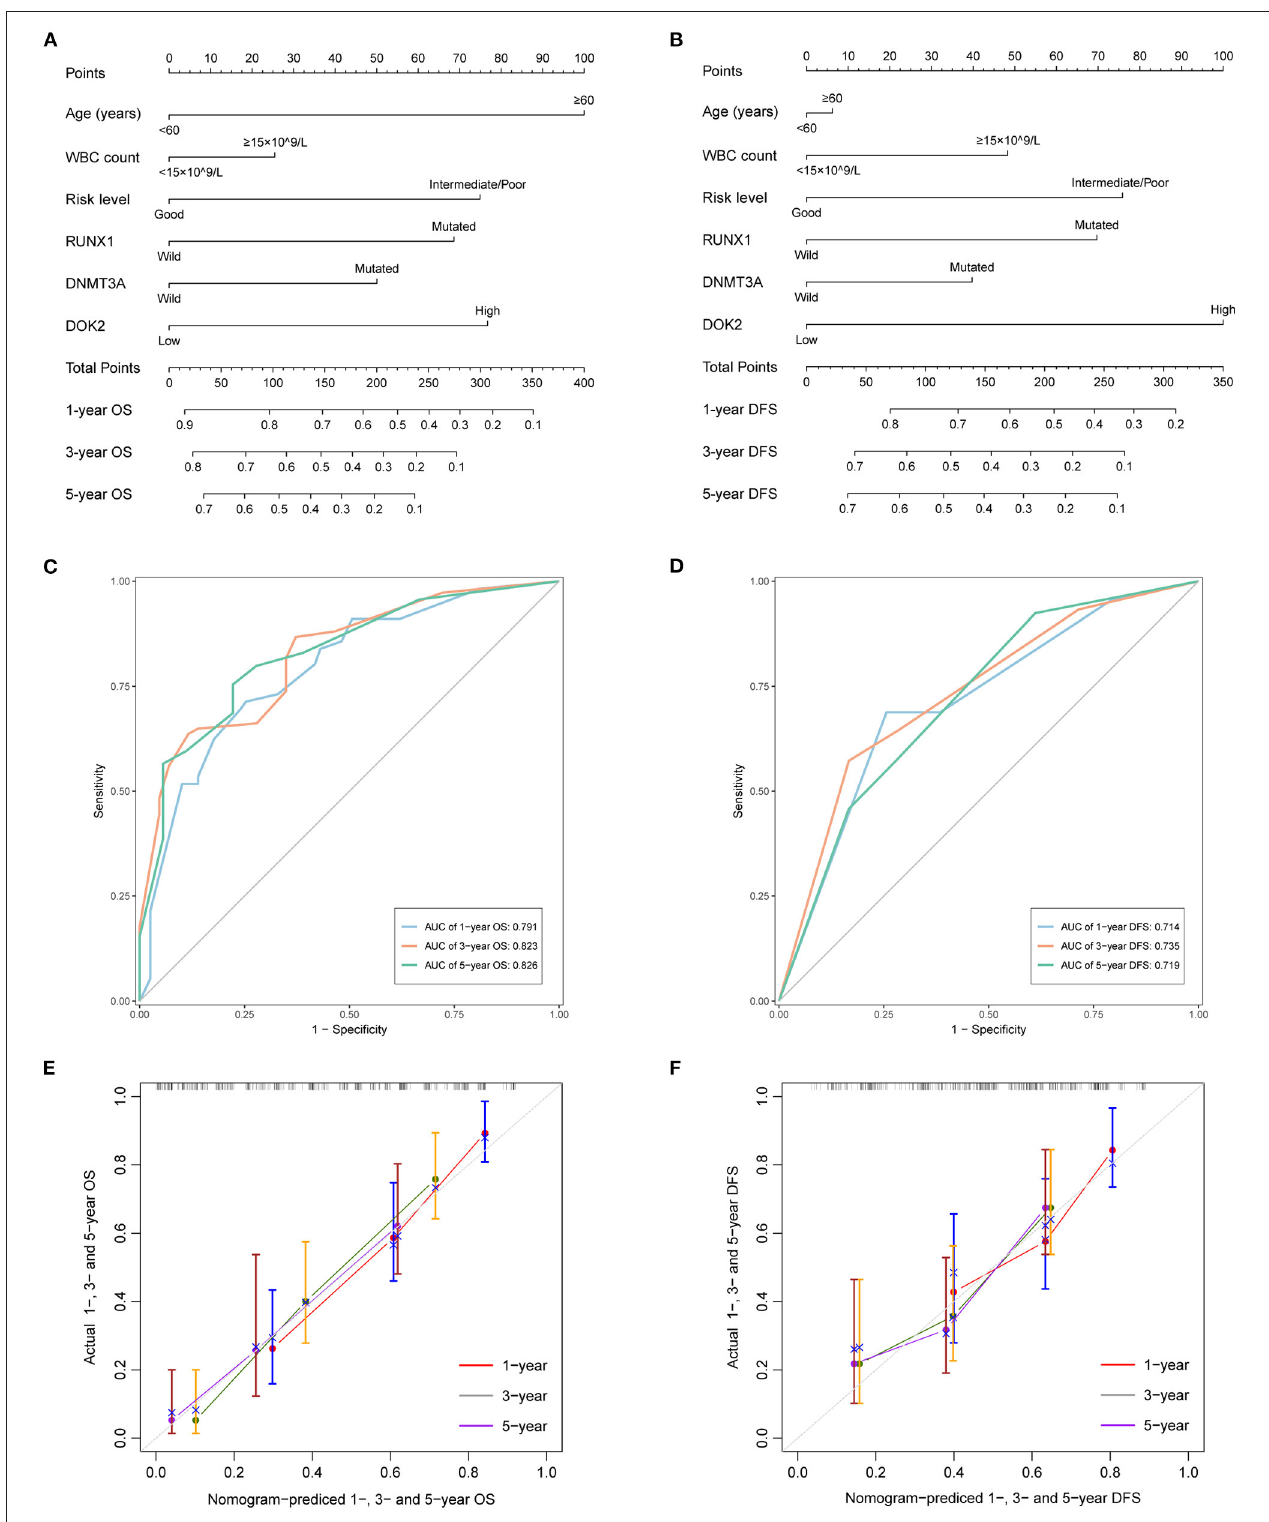
FIGURE 4 | Predictive nomograms for TCGA AML patients. (A) Nomogram for predicting 1-, 3-, and 5-year OS. (B) Nomogram for predicting 1-, 3-, and 5-year DFS. (C) The ROC curve and AUC value of nomogram for OS. (D) The ROC curve and AUC value of nomogram for DFS. (E) Calibration plots of the nomogram for 1-, 3-, and 5-year OS. (F) Calibration plots of the nomogram for 1-, 3-, and 5-year DFS.